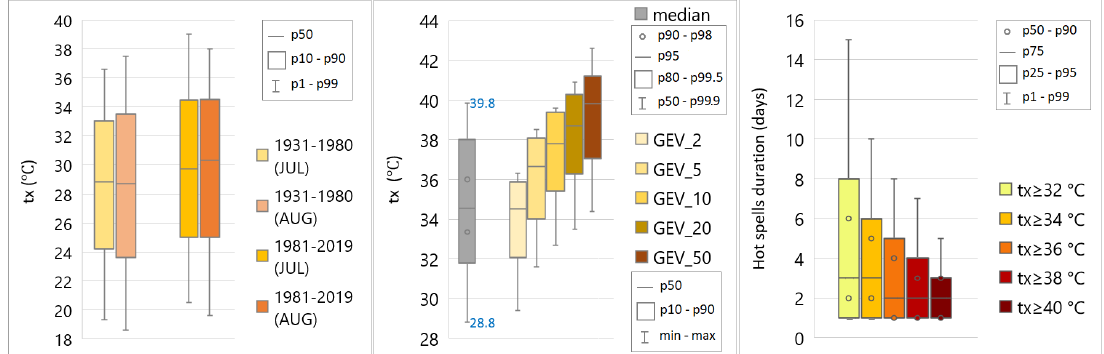
Figure A3. Left panel: Medians of calculated percentiles of tx -distributions by stations for 1931–1980 and 1981–2019. Middle panel: Median of calculated upper percentiles of tx -distributions and 2- , 5-, 10-, 20-, and 50-year return levels (estimated by GEV model) by stations for July–August (1931–1980). Right panel: Box plot of distributions of hot spells duration at the different tx -thresholds for